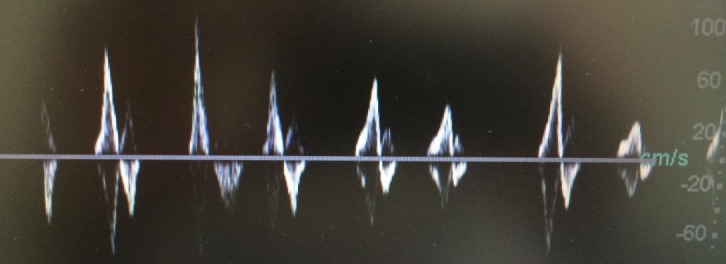
Fibrilação atrial.